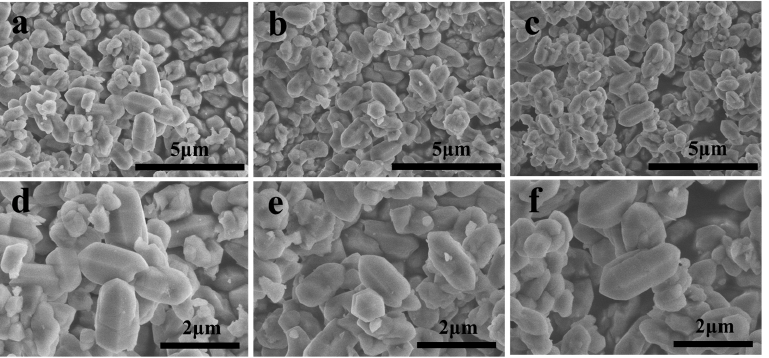
Figure 4. SEM images of Cu-SSZ-16-Fresh ( a , d ), CuCe 0.77 -SSZ-16-Fresh ( b , e ), and CuCe 0.87 -SSZ-16- Fresh ( c , f ). Fresh ( c , f